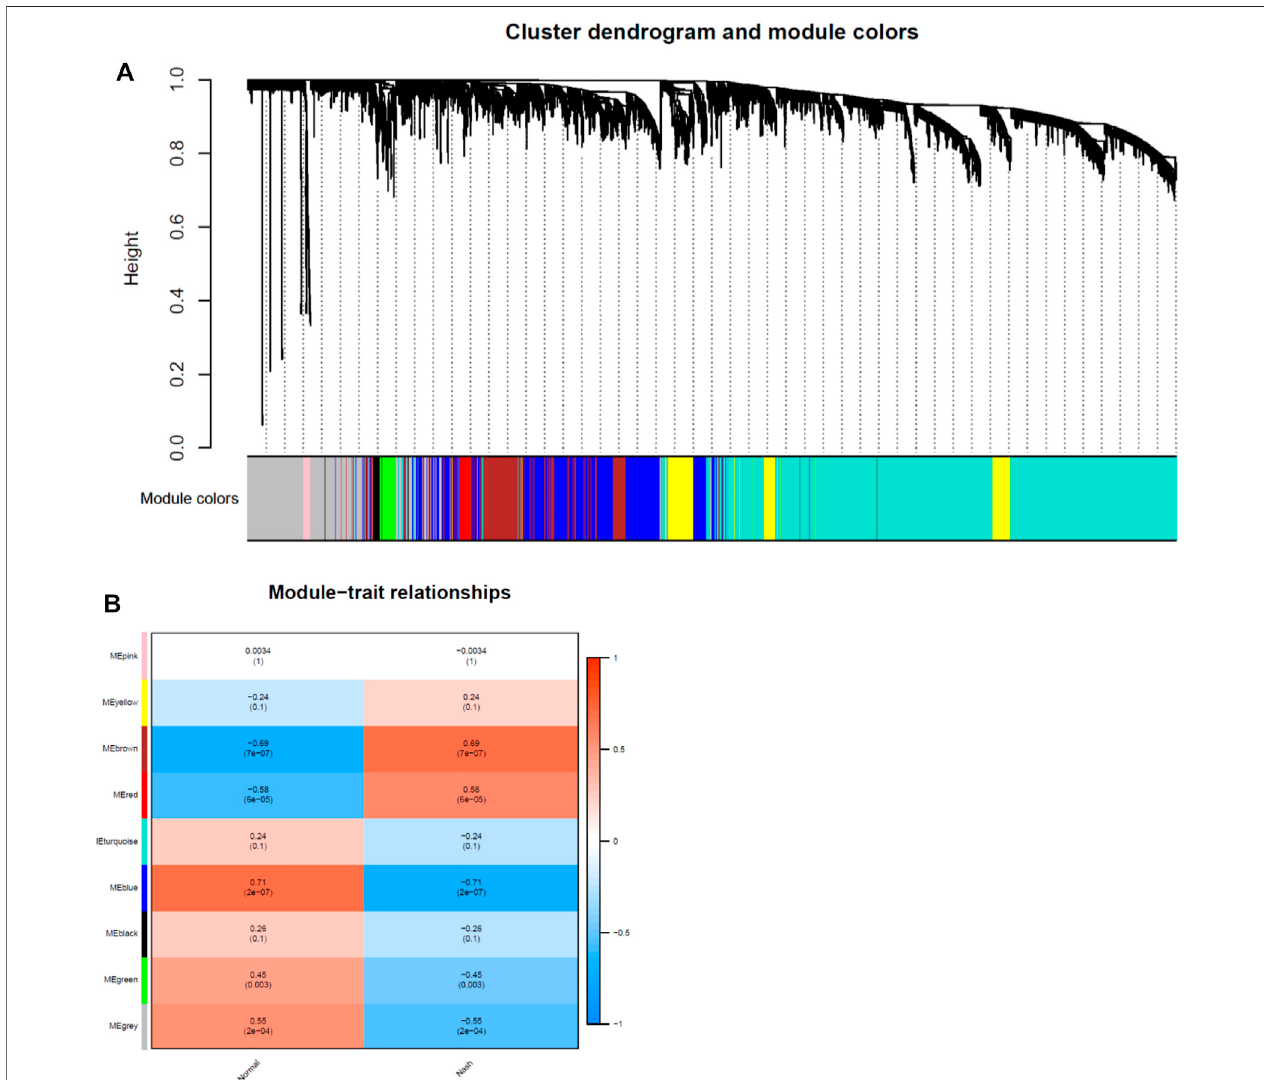
FIGURE 3 | Identi fi cation of modules associated with clinical traits in GSE89632 dataset. (A) The Cluster dendrogram of co-expression network modules was orderedbyahierarchicalclusteringofgenesbasedonthe1-TOMmatrix.Eachmodulewascoloreddifferently. (B) Module-traitrelationships.Eachrowcorrespondstoa module and column corresponds to a clinical trait (NASH or HC). Each cell includes the corresponding correlation and p